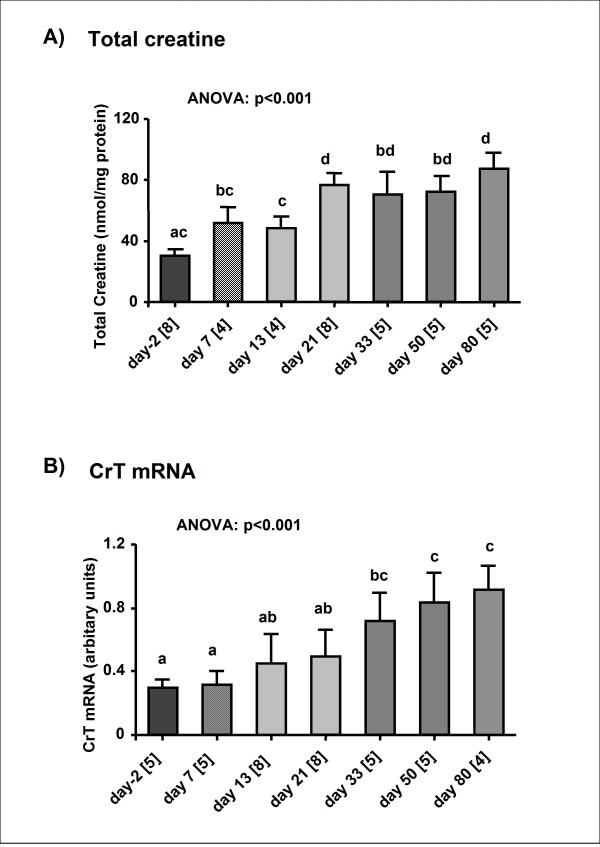
Total creatine content and creatine transporter mRNA in rat heart during maturation. A). Myocardial total creatine content in rats aged -2, 7, 13, 21, 33, 50 and 80 day old. B) Creatine transporter (CrT) mRNA levels in rat heart during maturation. Total RNA was isolated from foetal hearts on day 20 of gestation (2 d before birth), and 7, 21, 33, 50 and 80 d after birth. The level of CrT mRNA was measured by real-time RT-PCR and normalized to β-actin. Values are mean ± S.E. and sample size are given in brackets on the labels of the X axis. Data points not sharing the same superscript letter indicate total creatine and mRNA level respectively are significantly different to all others (p < 0.05 Bonferroni, ANOVA "test for linear trend": p < 0.001).